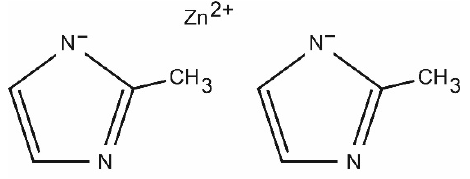
Figure 2. Chemical structure of ZIF − 8.